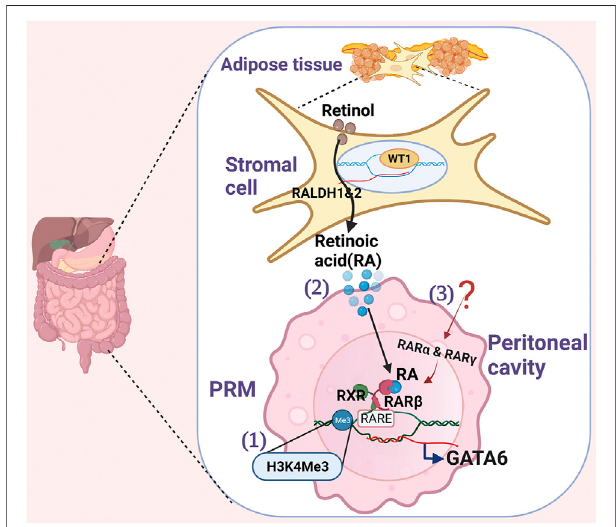
FIGURE 1 | Schematics show the regulation of GATA6 in PRMs. 1) Histone lysine methylation (H3K4me3) modi fi cation at the GATA6 locus in PRMs facilitates active GATA6 transcription. 2) Stromal cells express Wilms ’ Tumor 1(WT1) transcription factor for retinal dehydrogenase 1 and 2 enzymes that convert retinol to Retinoidc acid (RA). To induce GATA6 transcriptioninPRM,Retinoidacidreceptor β (RAR β )needstobeactivatedby RA, and both RAR β and retinoid X receptor (RXR) need to bind retinoic acid response elements (RAREs). 3) Other retinoic acid receptors (RAR α and RAR γ ) induced by yet unidenti fi ed stimuli at PRMs also collaborates with the RA-driven GATA6 transcription.